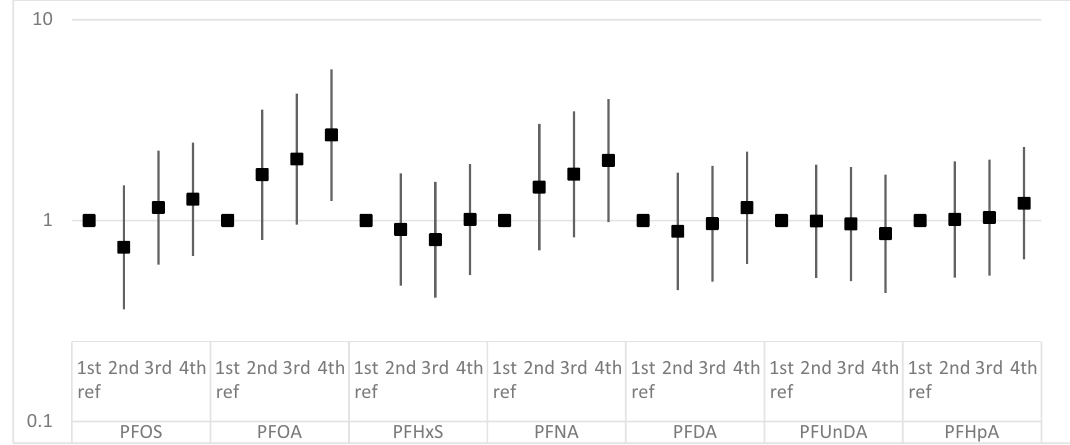
Figure 2. Adjusted associations 1 (Odds Ratios with 95% Confidence Intervals) between seven PFASs and miscarriage, presented by quartiles of exposure with respectively first quartile exposure as